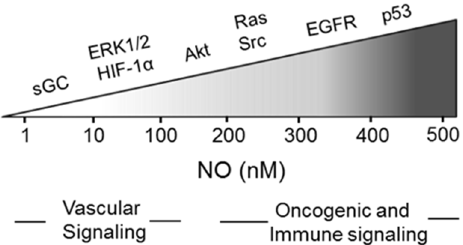
Figure 2. Nitric oxide activation of pro-tumor signaling pathways; NO concentration thresholds for activation of key mediators. (Adapted from Reference [19]).